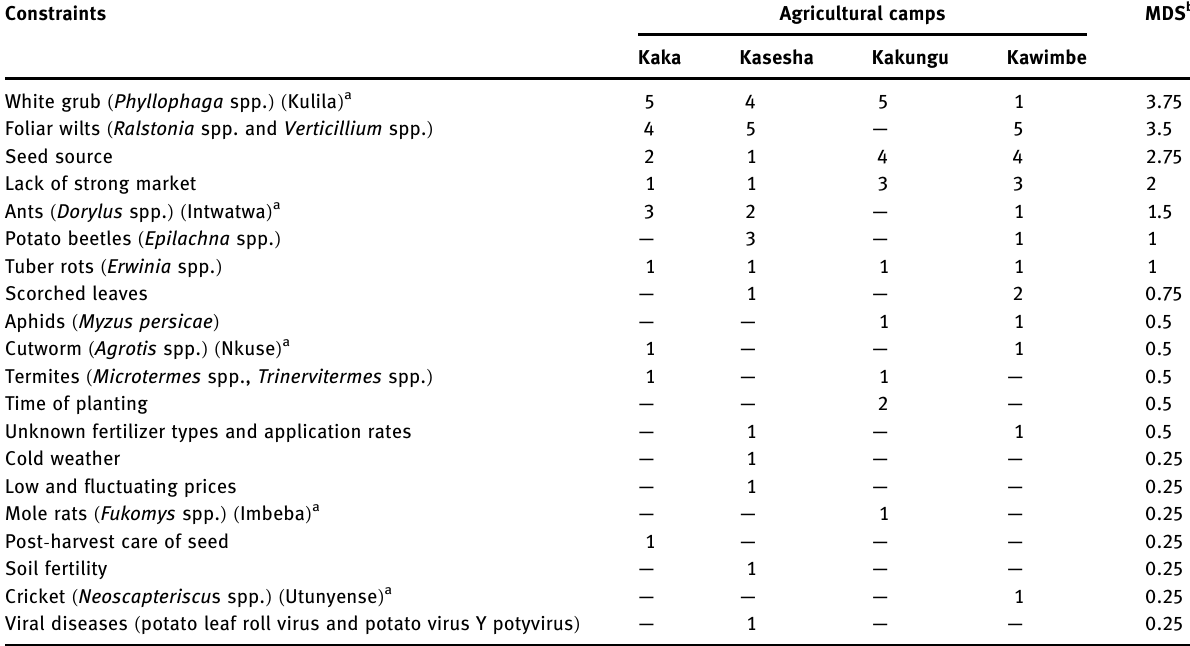
Table 6: Farmers ’ rating constraints of potato production in four agricultural camps of Mbala district during August 2018 Survey Constraints